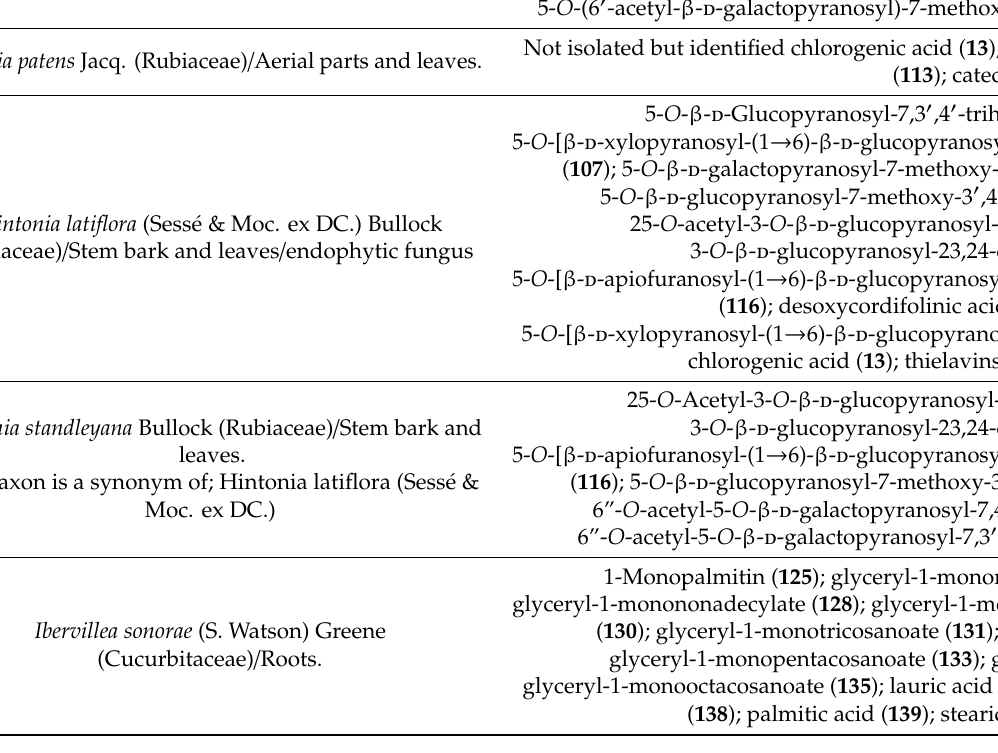
Plant / Family / Part Isolated Compounds Ref.